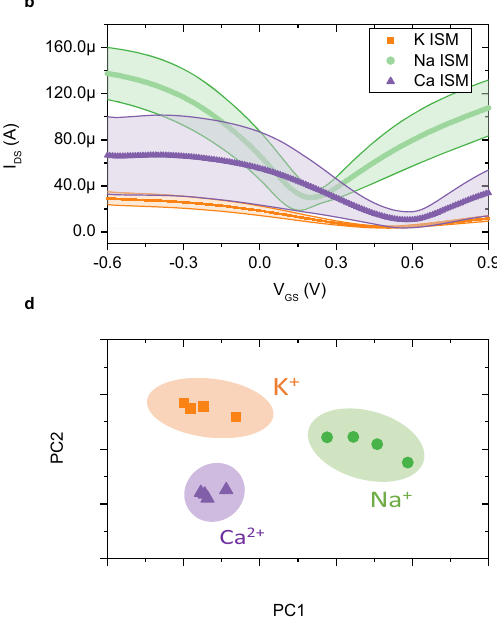
indicate an error band of plus or minus one standard deviation. Different colors indicatesensorsfunctionalizedwithdifferentISMs. c DiracPointsoftheintegrated sensing chip in solution containing various Na + ion concentrations. Error bars indicateplusorminusonestandarddeviationoftheDiracPointsofalltheworking devicesonthechip. d Principalcomponentanalysis(PCA)oftheintegratedsensing chip towards electrolytes comprised of different of ions using Dirac Points as fea- ture